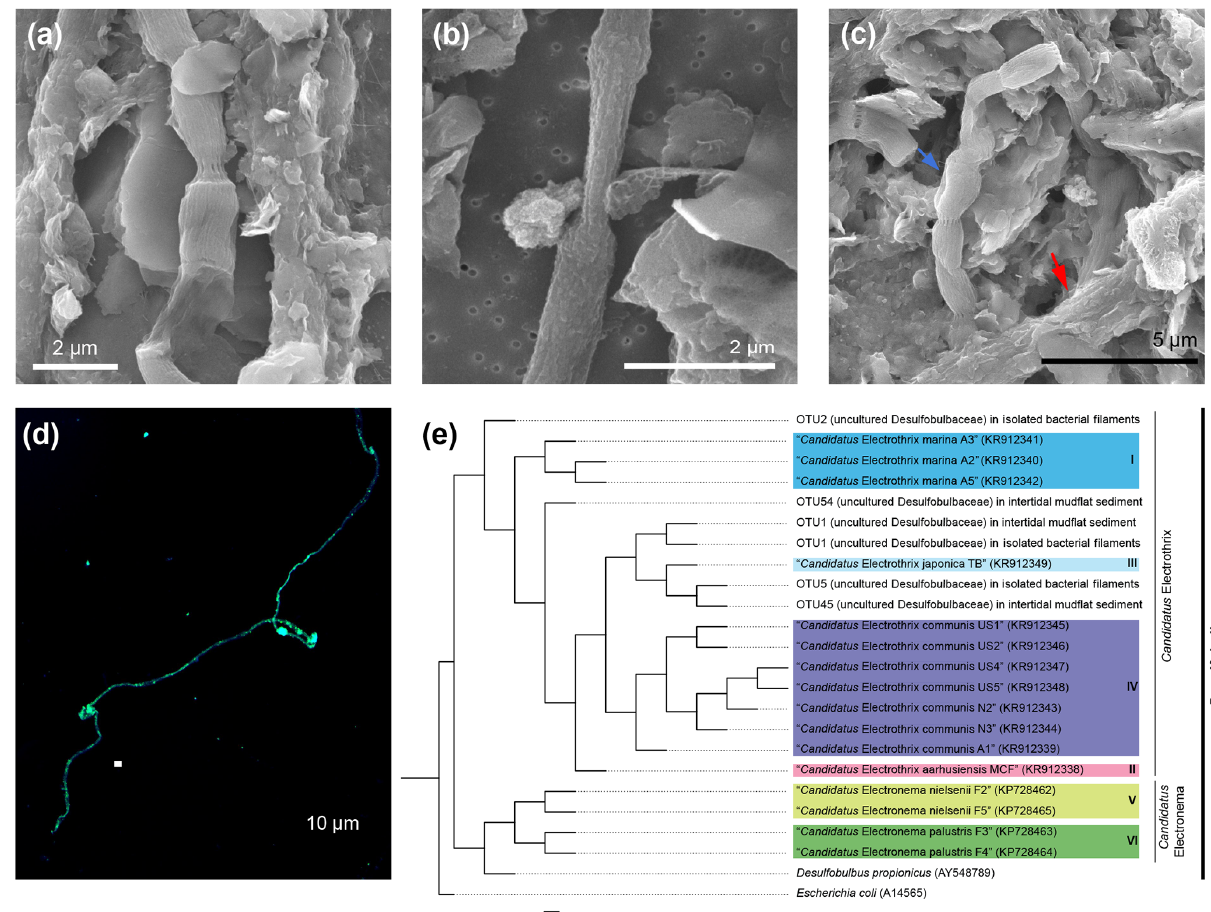
Figure 3. Cable bacteria filaments recovered from Yaquina Bay sediments. (a) A cable bacteria filament under SEM. (b) A thin type of cable bacteria filament under SEM. (c) Multiple filaments of cable bacteria clumped together under SEM. The blue arrow indicates a section of cable, and the red arrow indicates a cable bacteria filament covered with a mineral coating. (d) Identification of the filaments belonging to Desulfobulbaceae using catalyzed reporter deposition–fluorescence in situ hybridization (DSB 706 probe + Alexa Fluor 488 in green and DSB DAPI in blue). (e) Phylogenetic tree of Desulfobulbaceae 16s rRNA gene sequences recovered from IMF sediment and extracted biomass samples. Color boxes indicate previously recognized species of cable bacteria. The scale bar shows 5% sequence